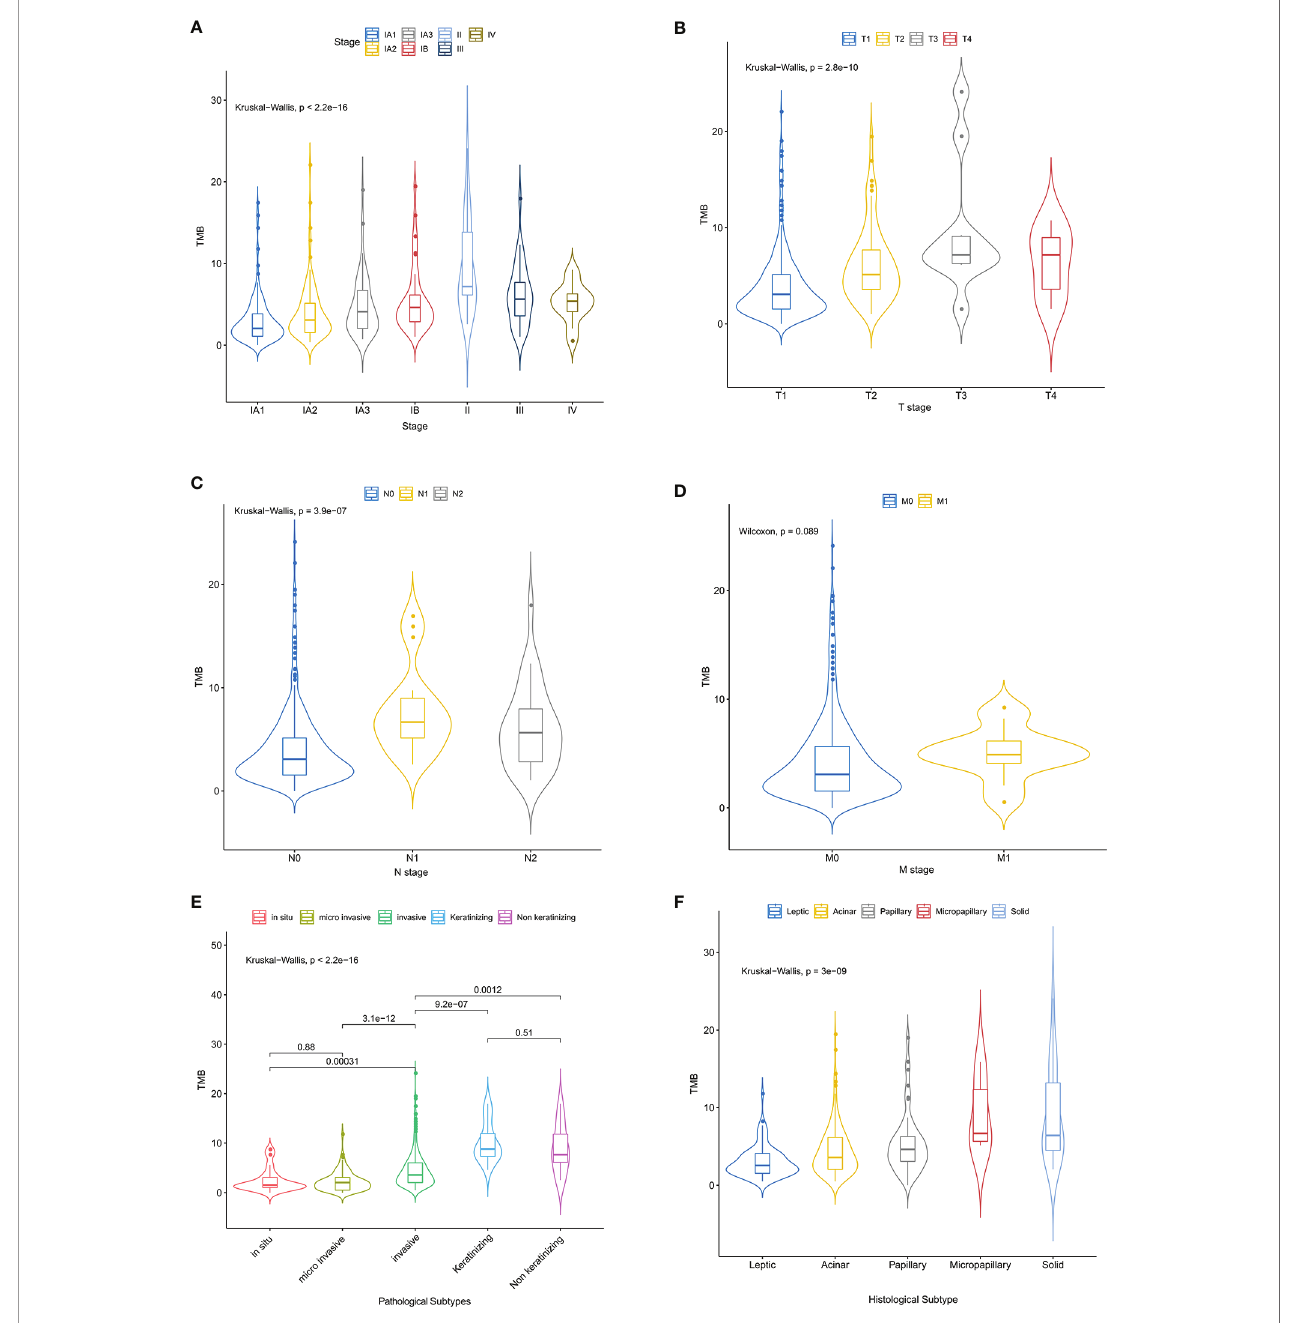
FIGURE 1 | The relationship between the TMB distribution and the tumor stages of NSCLC patients. Correlation analysis of TMB and TNM stage (A – D) , pathological (E) and histological subtypes (F)